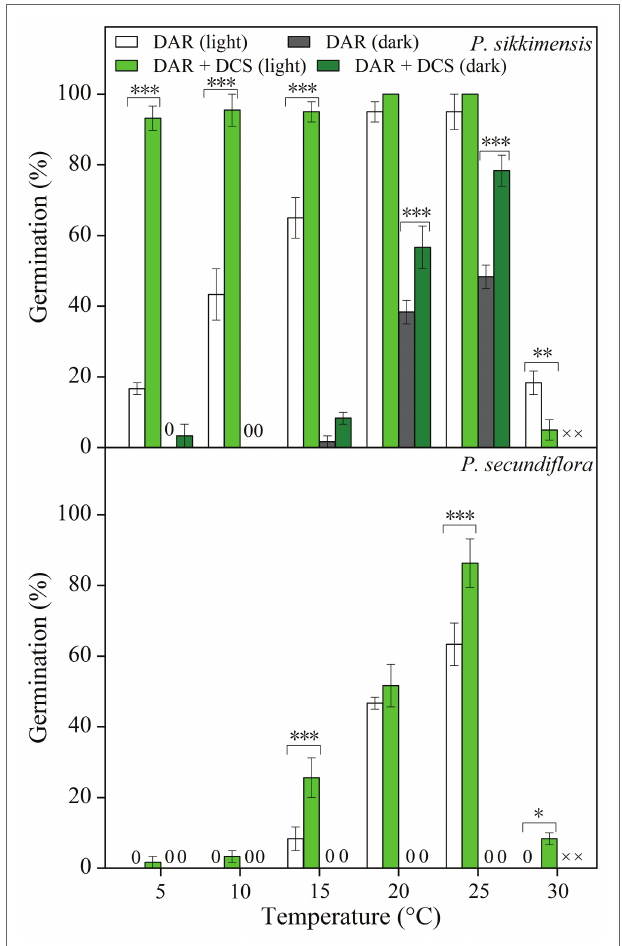
FIGURE 2 | Effects of temperature and dry cold storage treatments (DAR: dry after-ripened at room temperature for 6 months; DAR + DCS: dry cold storage at 4 ° C after DAR for 4 years) on germination of Primula secundiflora and Primula sikkimensis . Error bars indicate SE for three replicates of 20 seeds. Temperatures, dry cold storage, and light treatments are statistically significant ( p < 0.001 by GLM) in these two species. ×, no test in this treatment; 0, no germination with this treatment. Post hoc pairwise t -test comparisons (with Bonferroni adjustment) were carried out for each germination temperature. ∗ p < 0.05; ∗∗ p < 0.01; and ∗∗∗ p < 0.001, respectively. The unmarked bars showed no significant difference at each